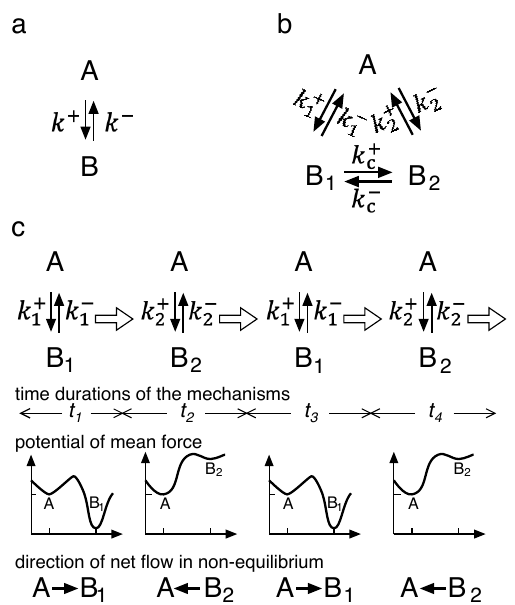
Figure 3. Chemical ratchet. ( a ) The simplest kinetic scheme composed of two states, A and B, which can be described with the rate constants ( k ± ). ( b ) The kinetic scheme when the B state is divided due to inhomogeneity in the reactant with two different activities. ( c ) The scheme of a chemical ratchet with two alternating mechanisms of reaction k ± and reaction k ± . The switching is indicated with 2 1 open arrows, and its timescale must not be faster (shorter) than that of the conversion between A and B i . Below the scheme, the time durations, potentials of mean force and the directions of net flow in non-equilibrium are shown. In the illustrations of the potentials, the abscissa is the reaction coordinate, and the ordinate represents the potential. These indications are omitted because of space-saving reason. Since the potential of B 1 < potential of A < potential B 2 , there is a net flow after potential switching that generates an oscillating